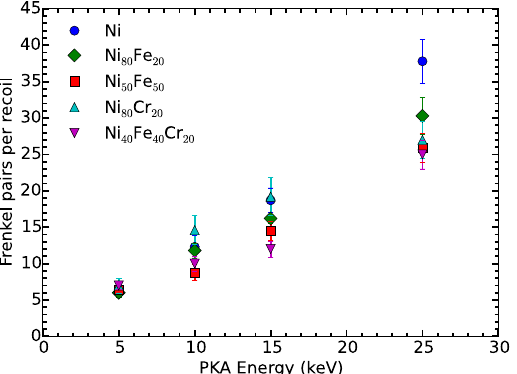
Figure 3. Comparison of number of Frenkel pairs. Number of Frenkel pairs produced in a single impact of 5, 10, 15 and 25 keV cascade energies. Data are taken as an average of ten simulations. Error bars show the standard error of the mean.